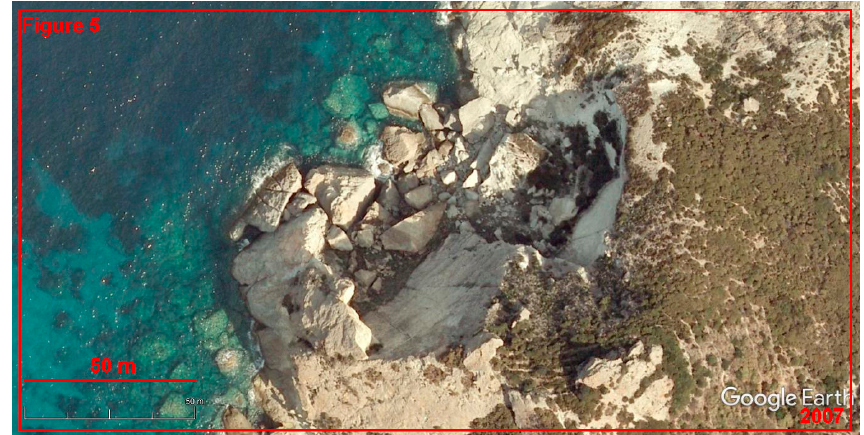
Figure 11. Satellite view of the western plot of the Hondarribia locality in 2001 (the view provided by the Google Earth Engine).